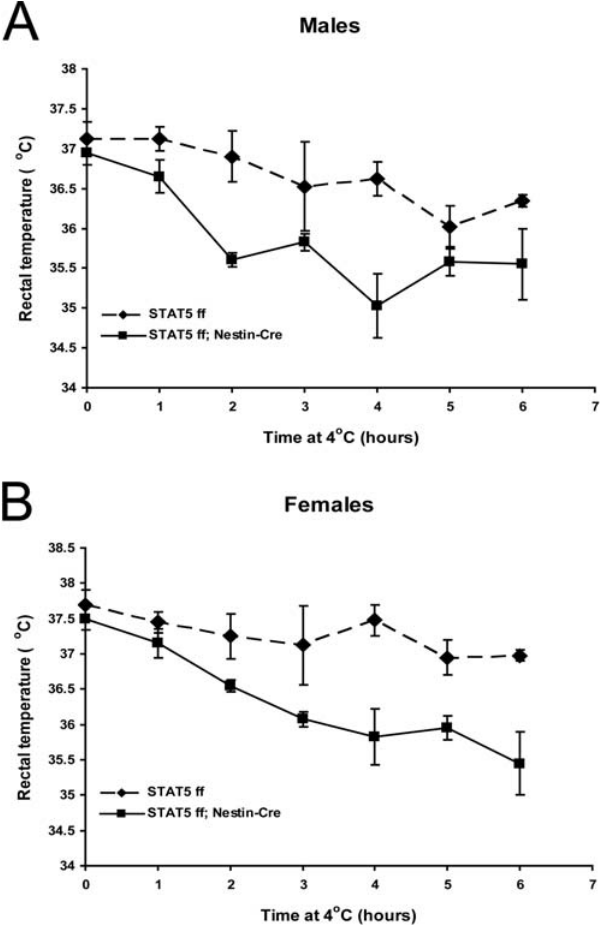
Figure 7. Stat5 fl/fl; Nestin-Cre mice are defective in cold-induced thermogenesis. 26 week-old Stat5 fl/fl and Stat5 fl/fl ; Nestin-Cre males (A) and females (B) were housed at 4 u C for 6 hours and rectal temperature was measured at 60-min intervals. The reduced cold tolerance in both males and females was statistically significant. N=4/group. Statistical analysis was done using ‘Two Way Repeated Measures ANOVA’ followed by the ‘Holm-Sidak test’. The effect of genotype was significant in both females (F(1, 36)=12.4, P =0.013) and males (18.2, P =0.005). The effect of length of cold exposure was also significant in females ( F (6,36)=9.5, P , 0.001) and males ( F (6,36)=6.9, P , 0.001